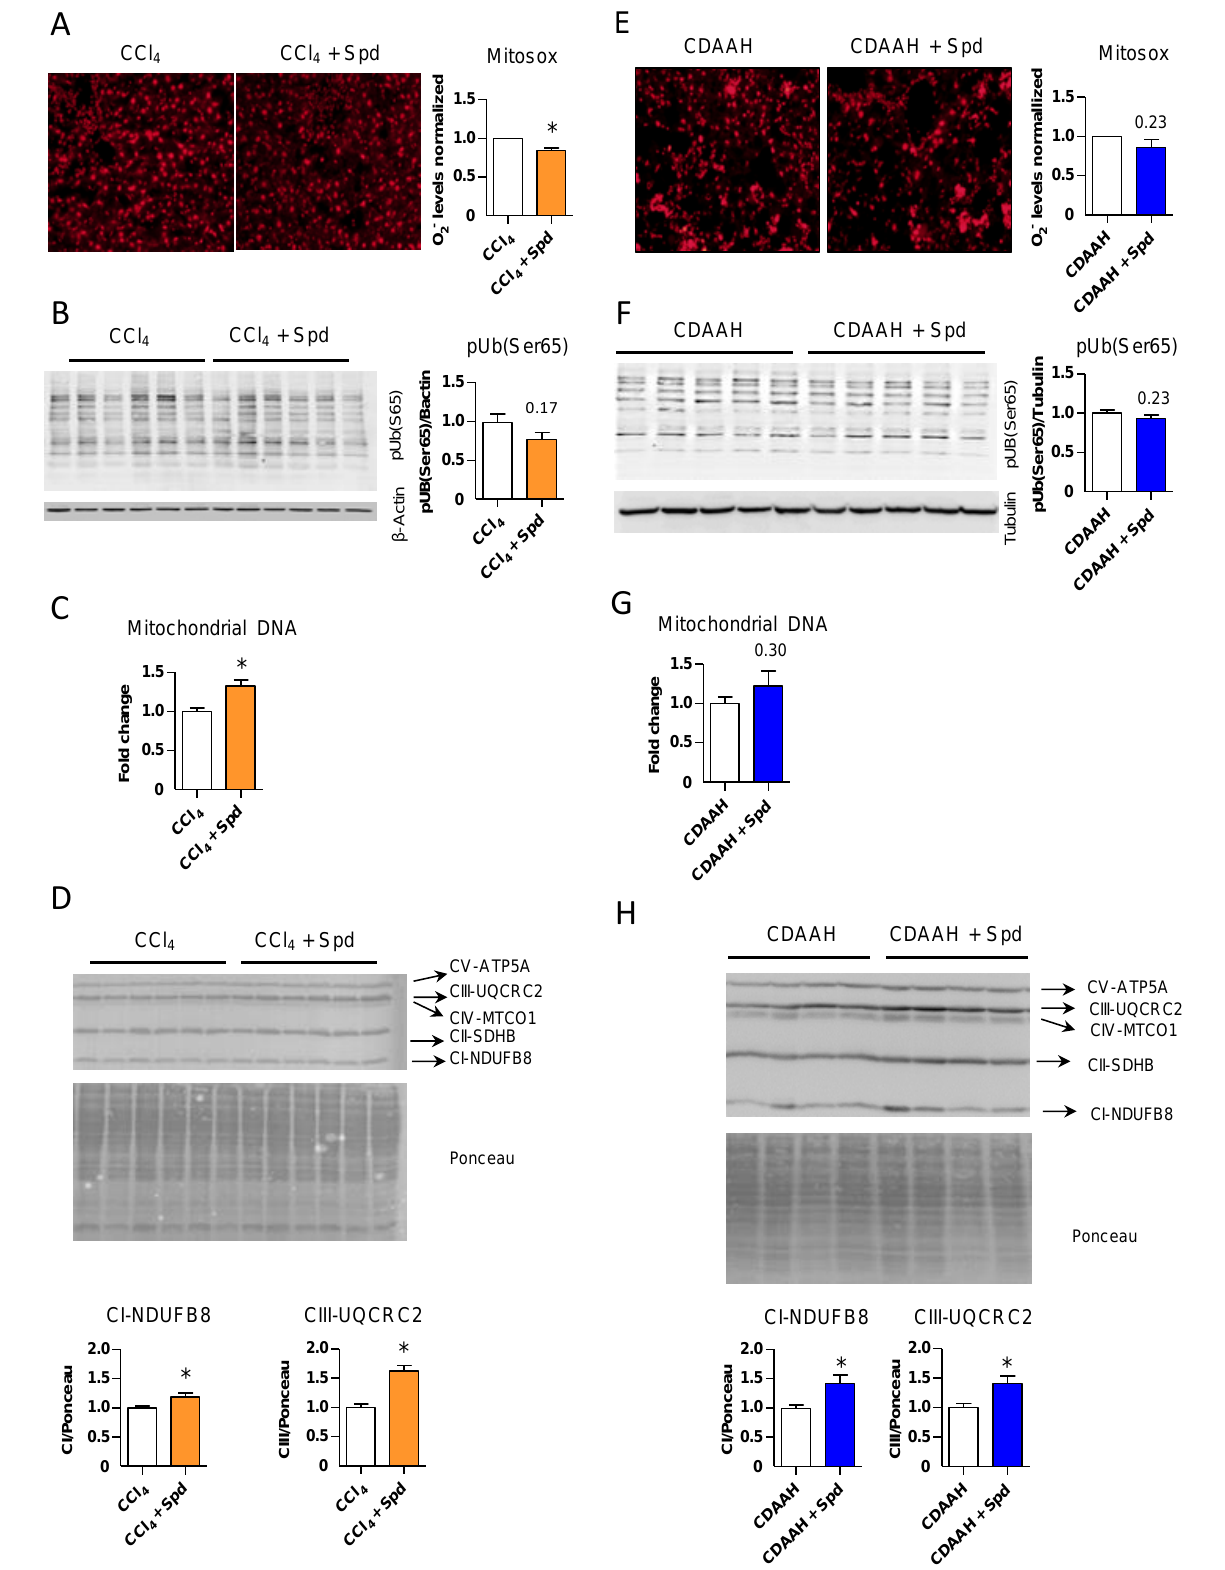
Figure 4. SPD alleviates oxidative stress and ameliorates mitochondrial stress signaling in vivo. ( A , E ) Superoxide quantifica- tion in the CCl 4 and CDAAH mouse livers treated with or without SPD by MitoSOXTM. The mice were sacrificed in pairs (+/ − SPD each time), the livers were excised and snap-frozen in dry ice. Ten µ m cryosections, each containing a piece of the two livers, were obtained in less than an hour and rapidly incubated with a 5 µ M MitoSOX TM solution for 10 min in the